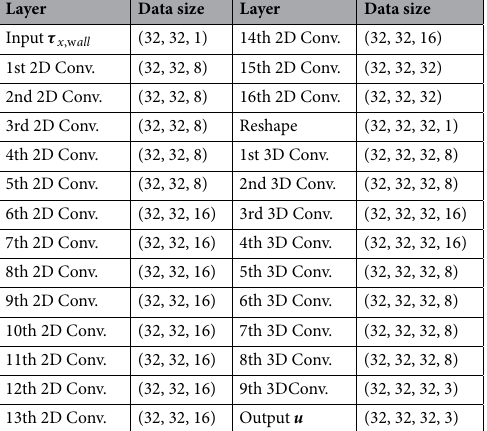
Table 1. Structure of 2D-3D CNN C for turbulent channel flow